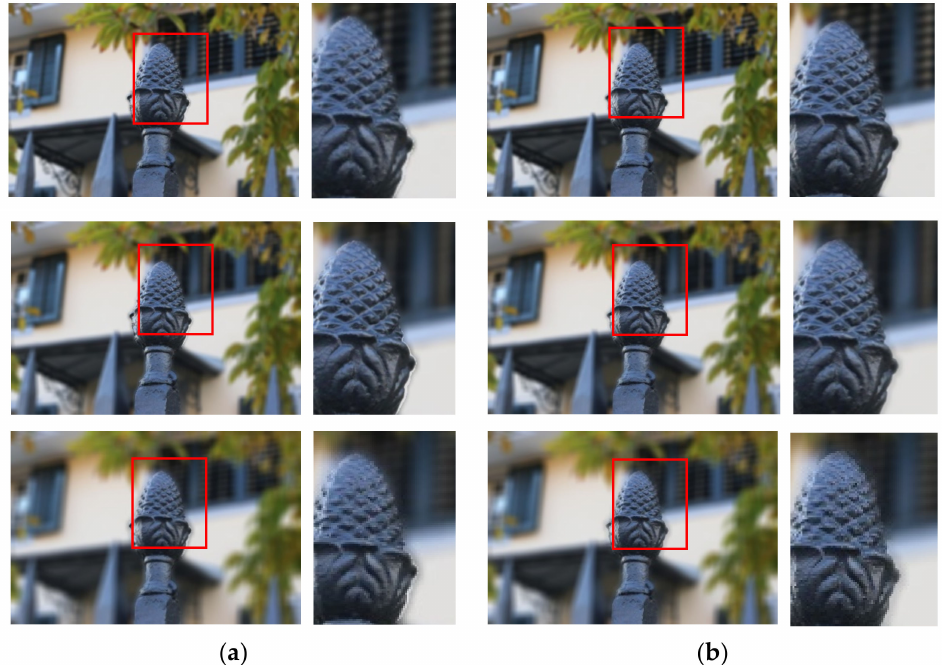
Figure 7. Uniform bokeh effect with Gaussian blur radius of 10, 15 and 20. ( a ) Uniform bokeh effect; ( b ) Uniform bokeh effect with smooth